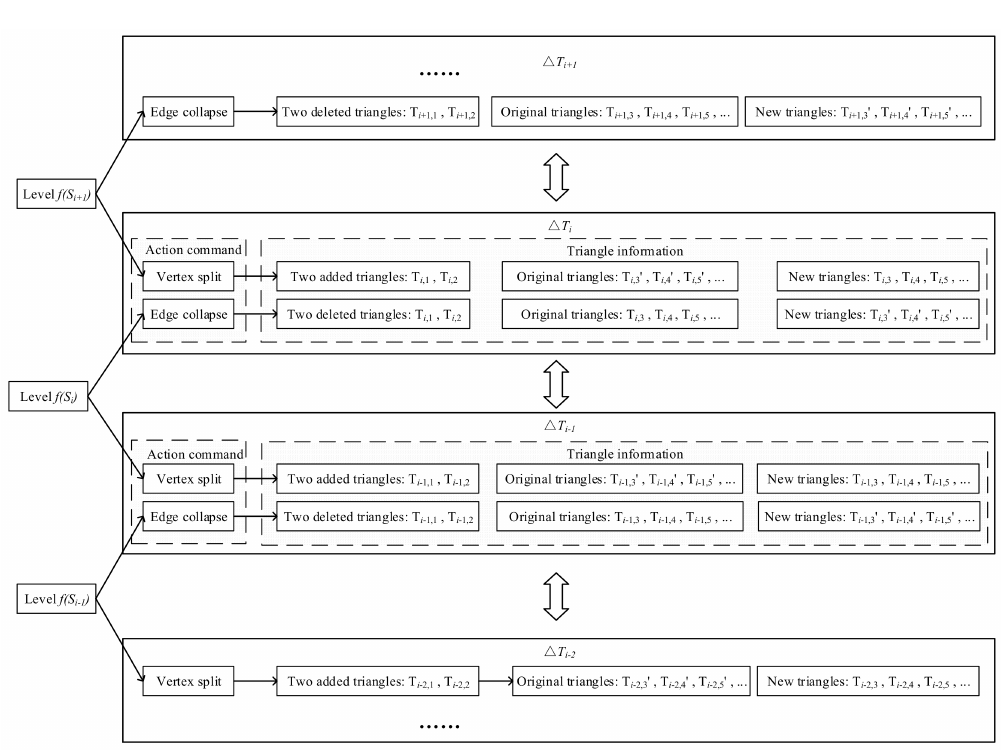
Figure 5. Storage structure of the incremental information. Level f ( S i ) represents the hierarchical model at the S i scale. T i , j is the information on the original triangles, and T i , j ’ is the information on the new triangles. i corresponds to the S i scale, and j is used to distinguish di ff erent triangles at the S i scale. The stored incremental information at the adjacent scales is represented as ∆ T i